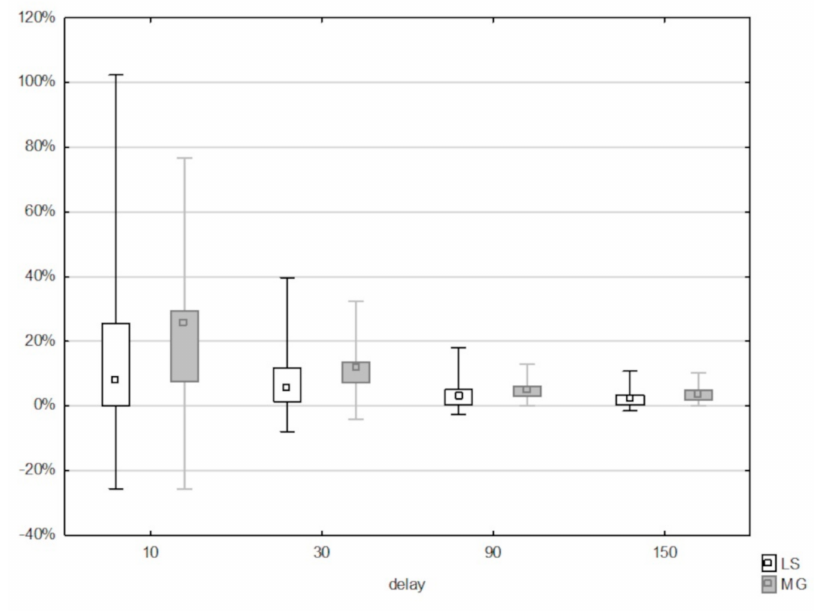
Figure 2. Box (median, Q1–Q3) and whiskers (Min-Max) chart for LS and